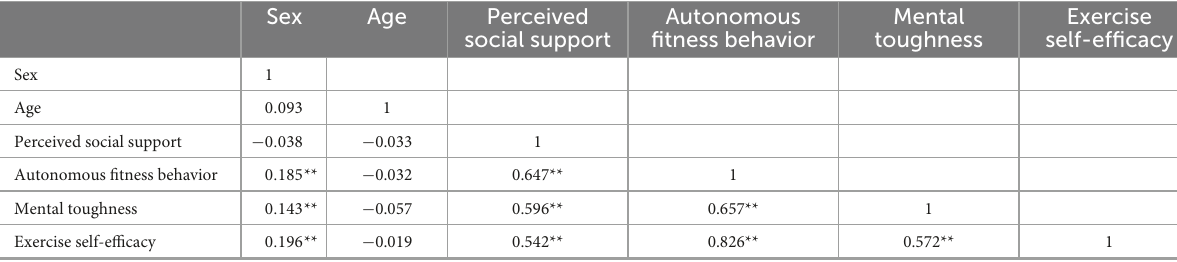
TABLE 1 Descriptive statistics and correlation analysis.